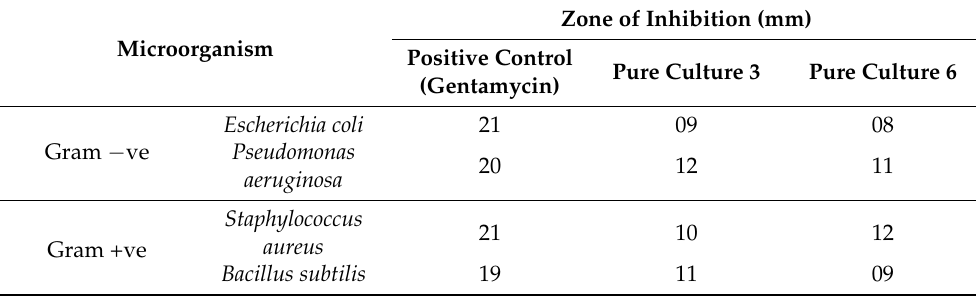
Table 1. Zone of inhibition (in diameter) due to isolated pure cultures of bacterial strains against Gram-negative bacteria ( Escherichia coli and Pseudomonas aeruginosa ) and Gram-positive bacteria ( Staphylococcus aureus and Bacillus subtilis ). The experimental data were collected in triplicate.